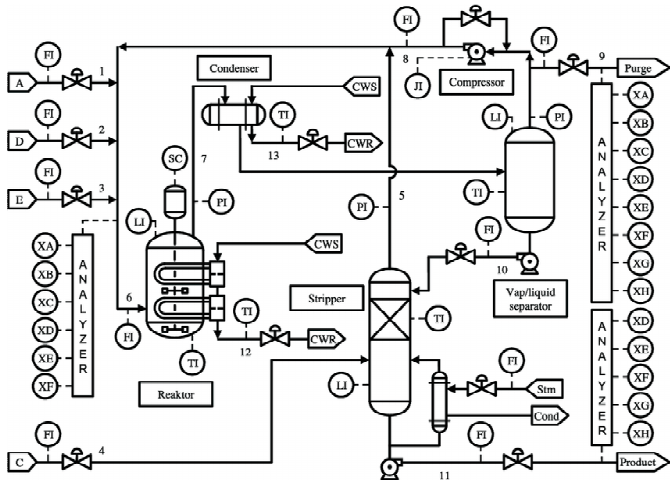
Figure 3. Diagram of the Tennessee Eastman Process (TEP) simulation [45]. Reproduced